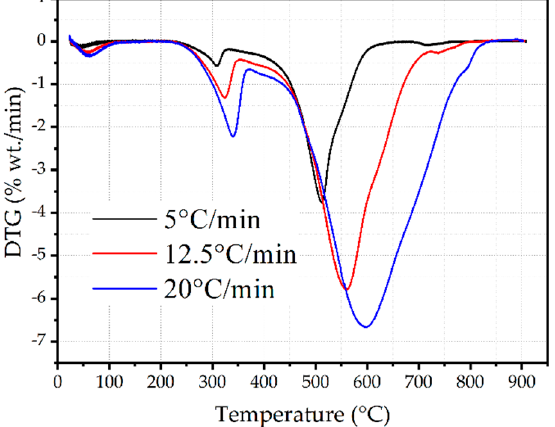
Figure 7. TG curves for 90HC10PS at 5, 12.5, and 20 °C/min heating rates under an air atmosphere.